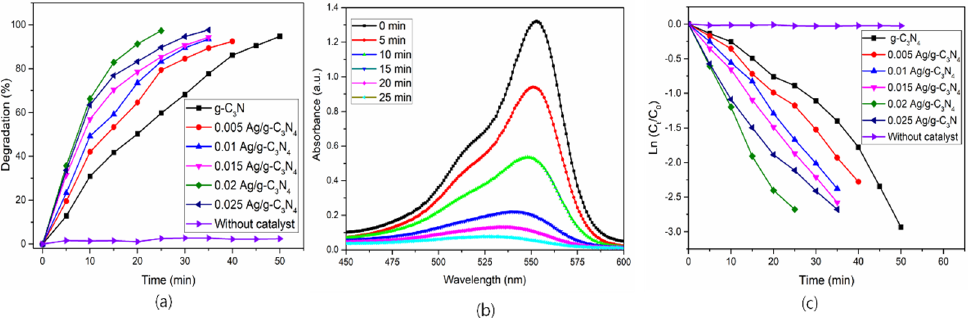
Figure 10. ( a ) Degradation of pollutant (RhB) under irradiation with prepared catalysts; ( b ) kinetics of the RhB with different intervals of irradiation time; ( c ) Ln Ct/C0 versus irradiation time.